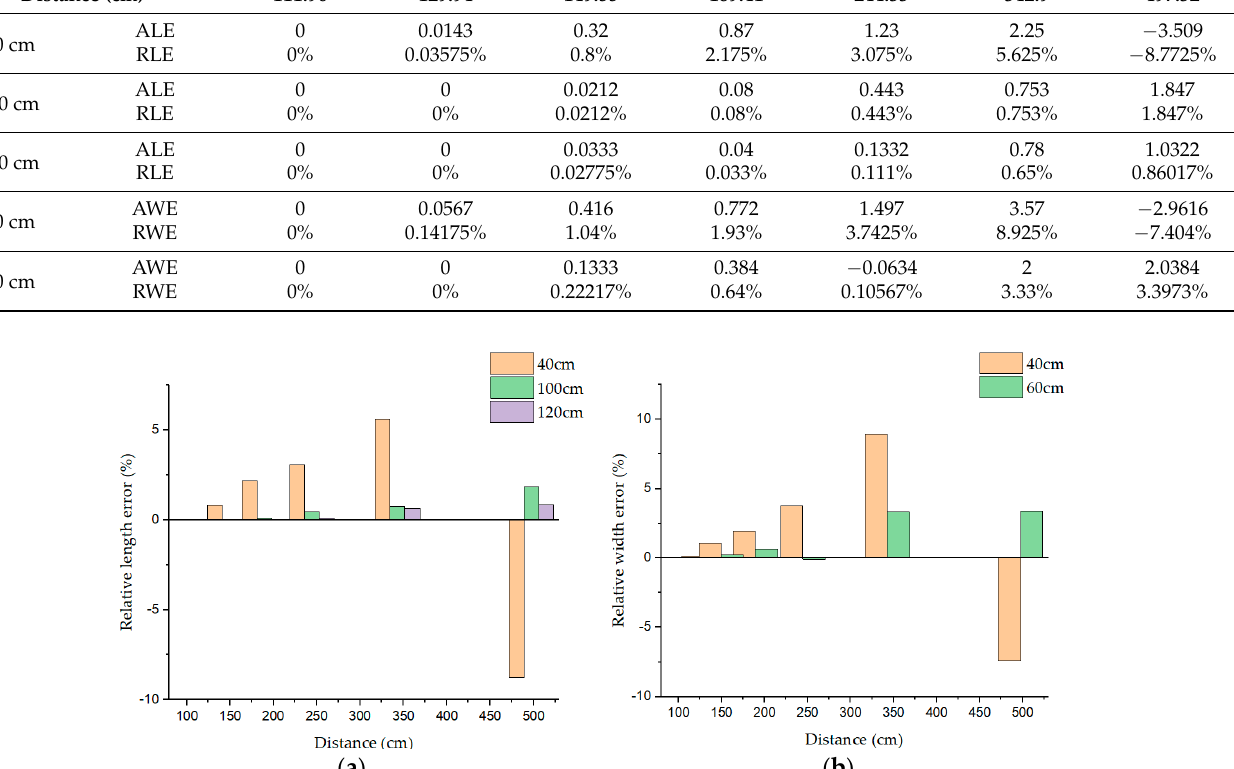
Figure 18. Verify the data error bar. ( a ) Verify the length data error bar; ( b ) verify the width data error bar. Table 4. Length and width error analysis table. Distance(cm)